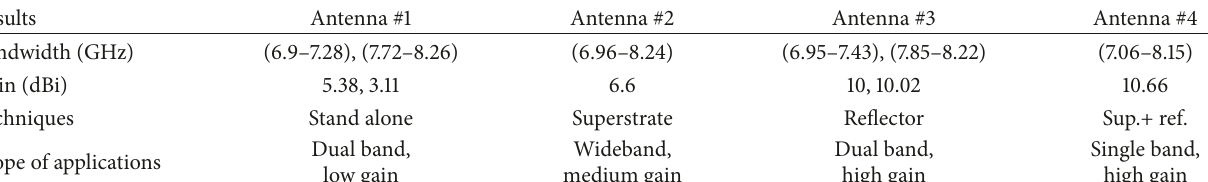
Table 1: Simulated performance comparison of developed antenna geometries.